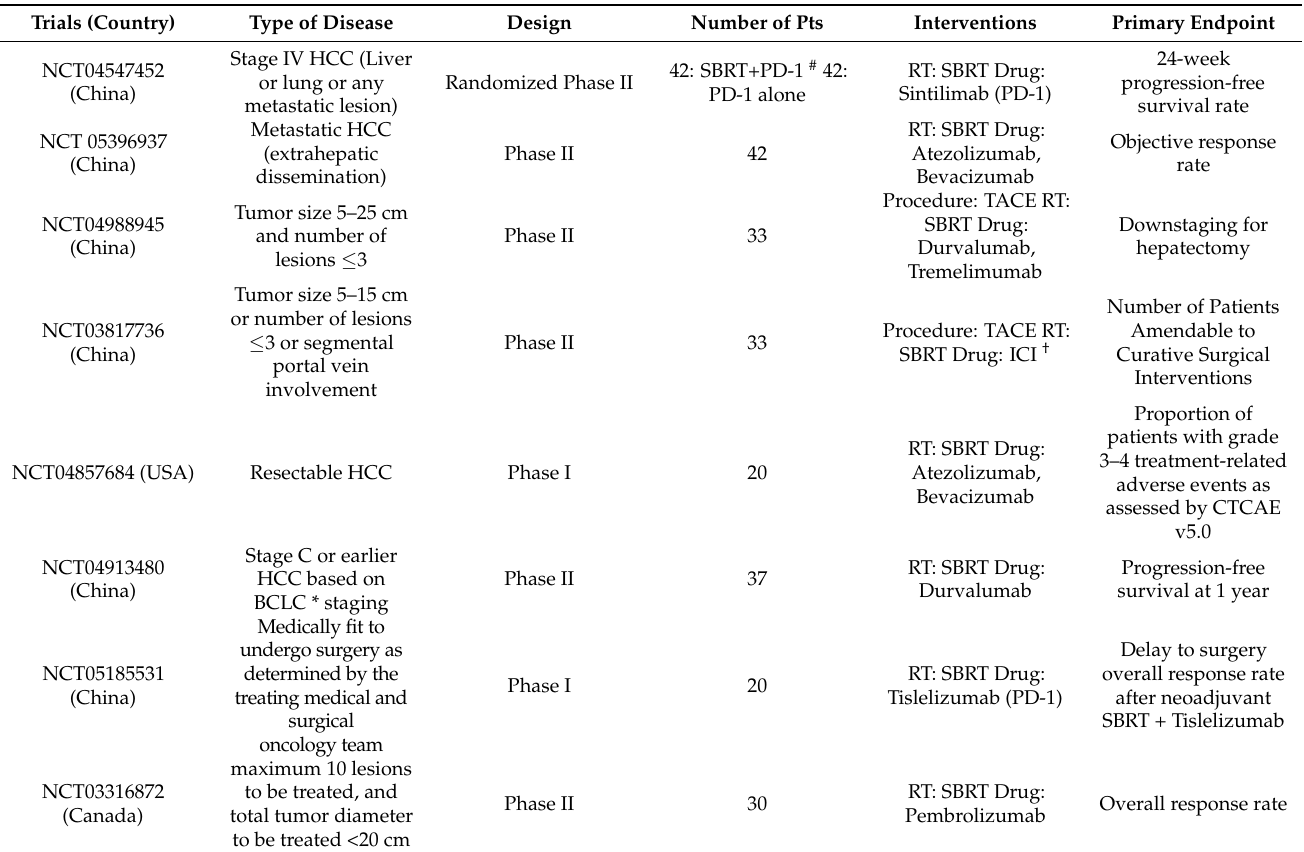
Table 5. Summary of ongoing prospective trials of immunotherapy combined with SBRT for advanced HCC. (ClinicalTrials.gov, accessed on 14 July